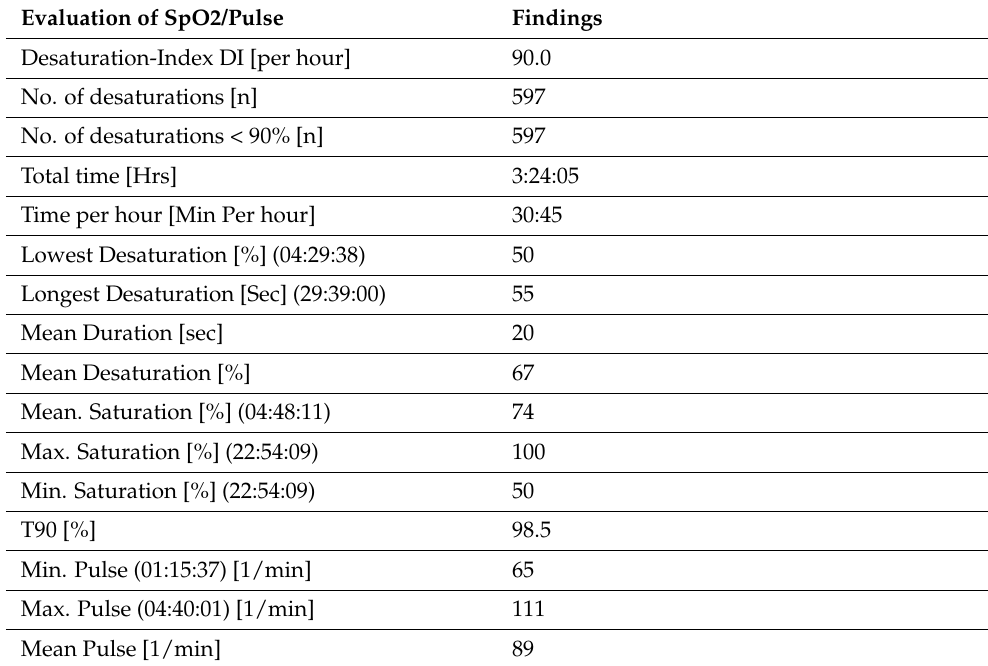
Table 2. Polysomnographic SpO2 and pulse parameters at presentation.